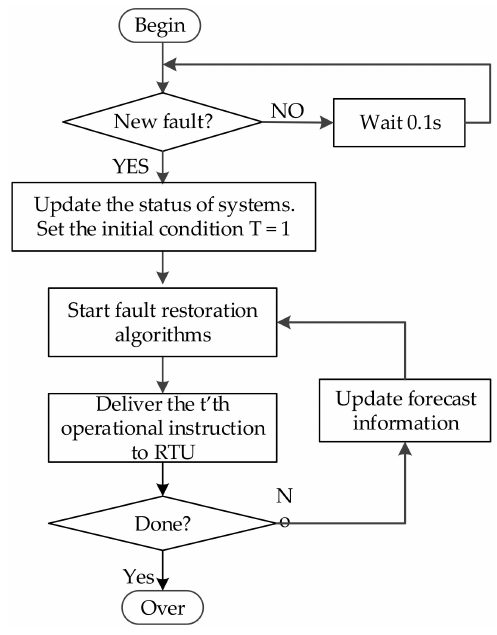
Figure 2. Flowchart of restoration in